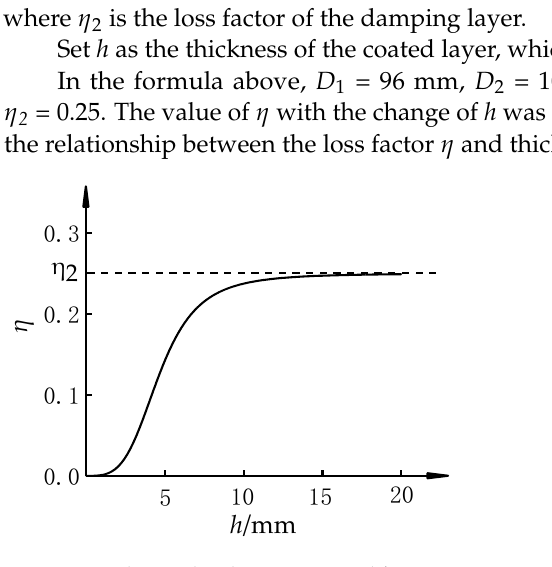
Figure 4. Relationship between η and h .